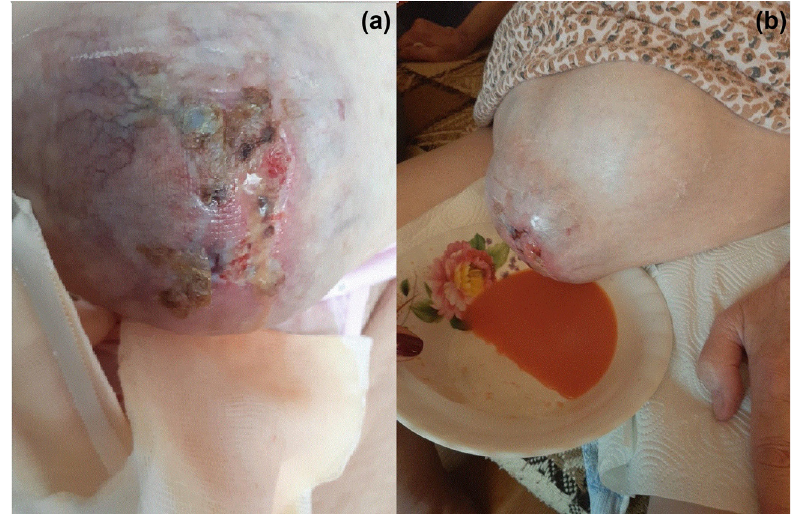
Figure 1: ( a ) Large metastatic lesion in fi ltrating peritoneum, omentum, fascia, subcutaneous tissue, and skin became visible due to increased ascites. ( b ) The cloudy orange fl uid was leaking out under high pressure from the PCF.